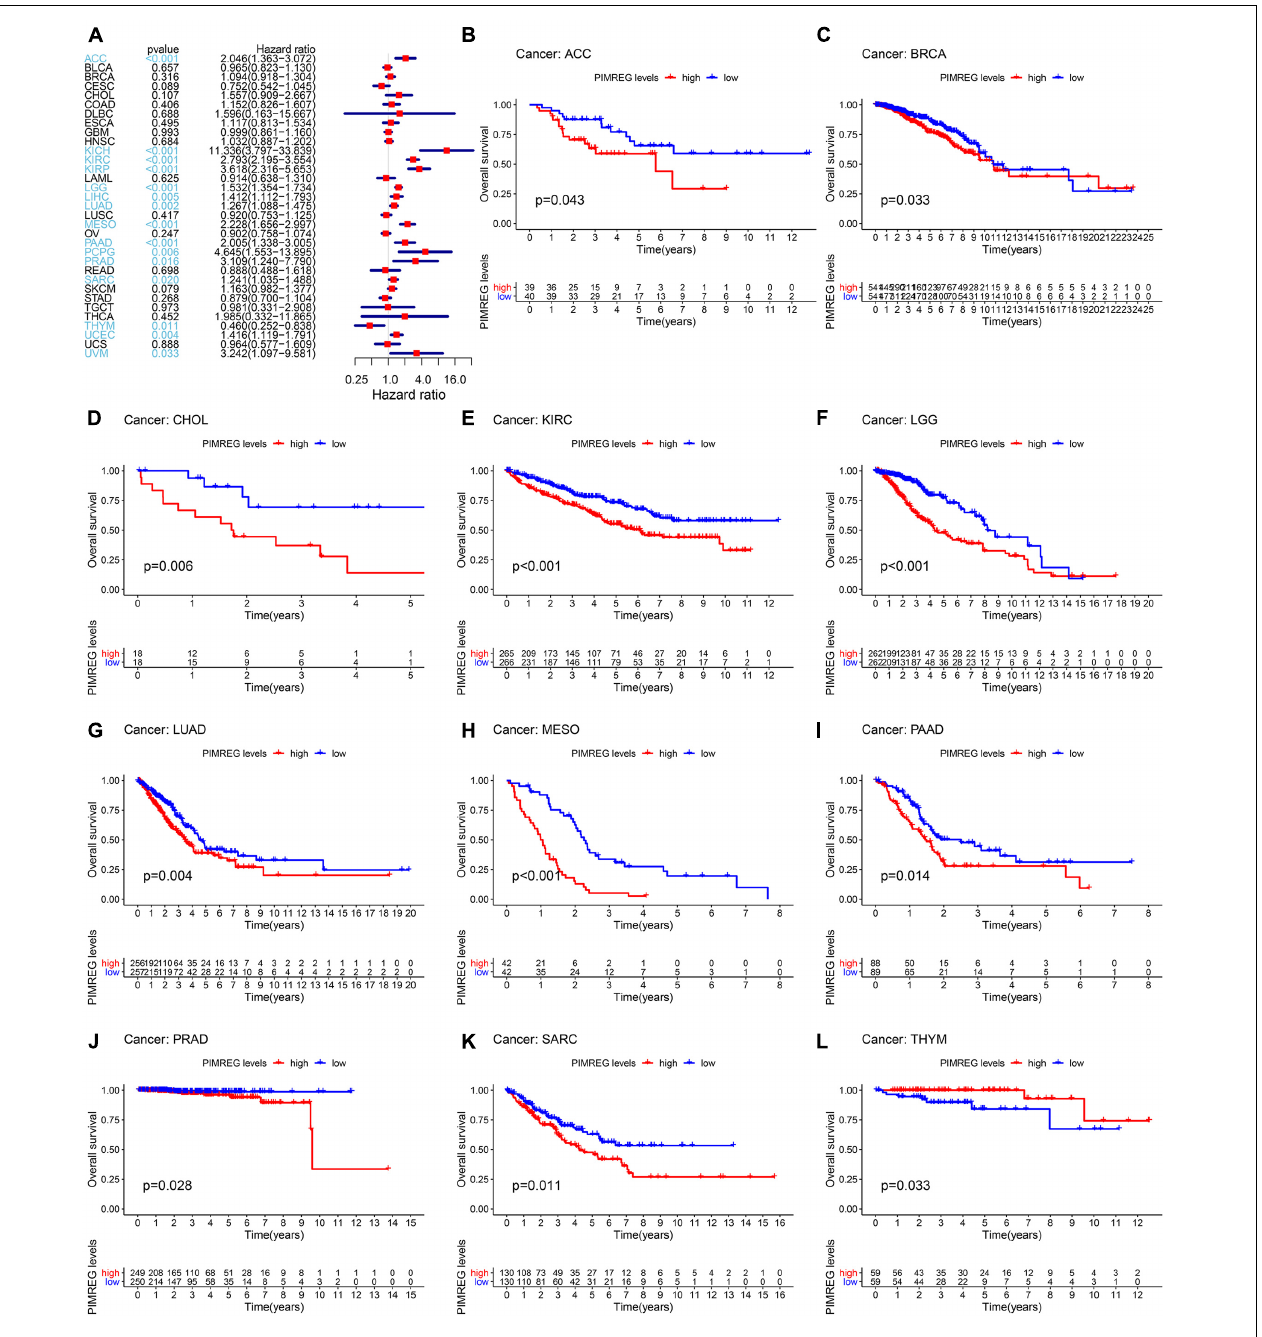
FIGURE 3 | Correlation of PIMREG expression with overall survival time (OS). (A) Forest plots of OS correlations in 33 cancer categories. (B–L) KM analyses of the correlation of PIMREG expression with